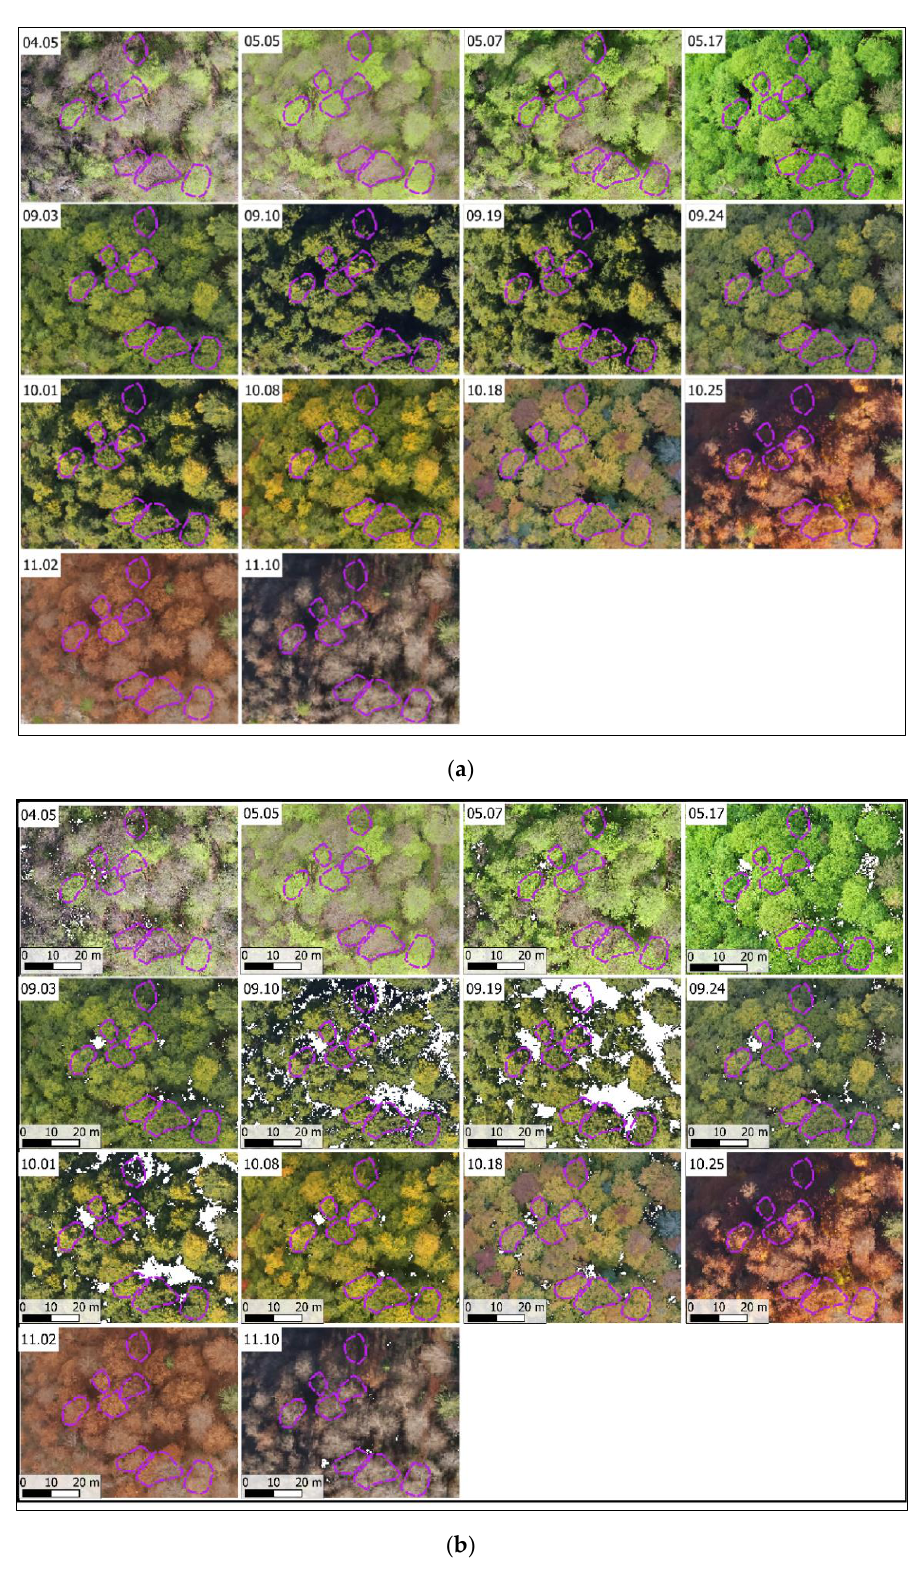
Figure A2. Example of images along the growing season timescale before ( a ) and after ( b ) removing shadows and changing the digital values of pixels to non-value. Dashed magenta regions represented crown delineation and were used to retrieve the RGB band length